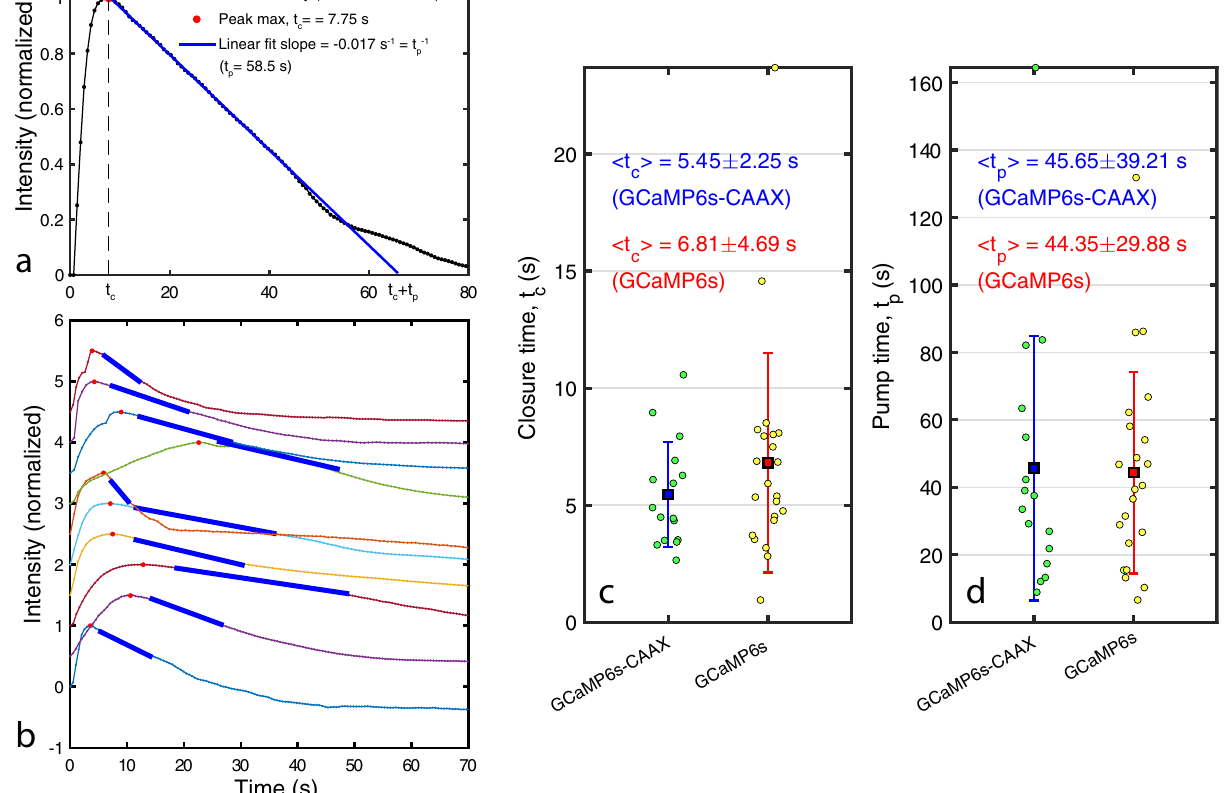
Figure 3. Plot of the calcium-probe (GCaMP6s-CAAX) intensity within the footprint of an MCF7 cell during laser damage and repair ( a ). Intensity is normalized to the maximum intensity reached. The peak maximum at t c is indicated (red dot) and a linear fit (blue line) to the intensity decrease during repair. The pump time t = time t p is defined as the inverse of the slope of the linear fit. Examples of 10 random intensity curves (probe: GCaMP6s-CAAX) with associated peak maxima and linear fits to the decay region ( b ). Curves in ( b ) are offset vertically for clarity. The distribution of measured closure times t c and the mean values for the GCaMP6s-CAAX (N = 16) and the GCaMP6s (N = 22) probes ( c ). The distribution of the pump times t p and the mean values for the GCaMP6s-CAAX and the GCaMP6s probes ( d ). Uncertainties in ( c , d ) are ± one standard